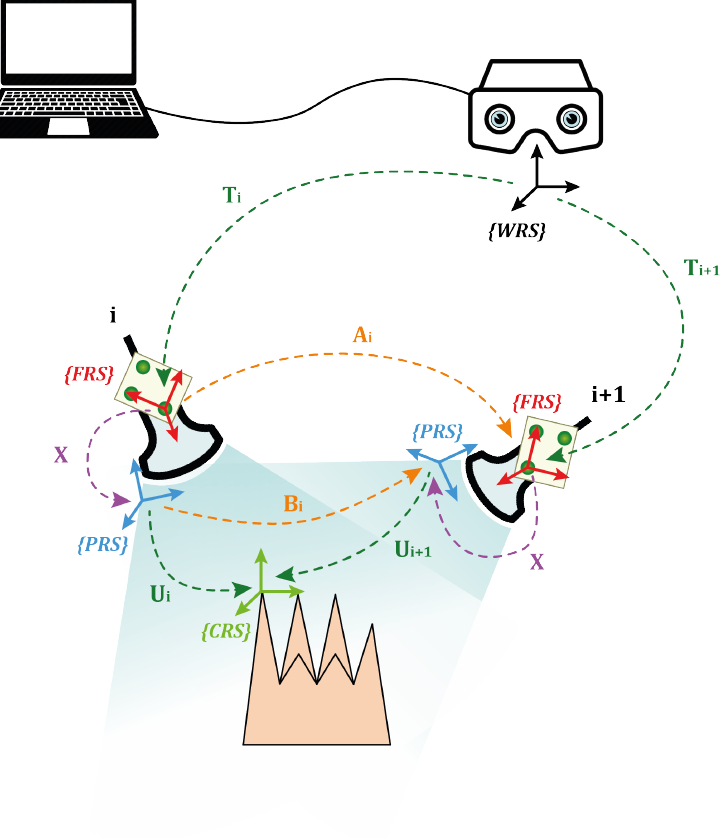
Figure 6. Illustration of the AX = XB procedure for the probe-to-optical frame